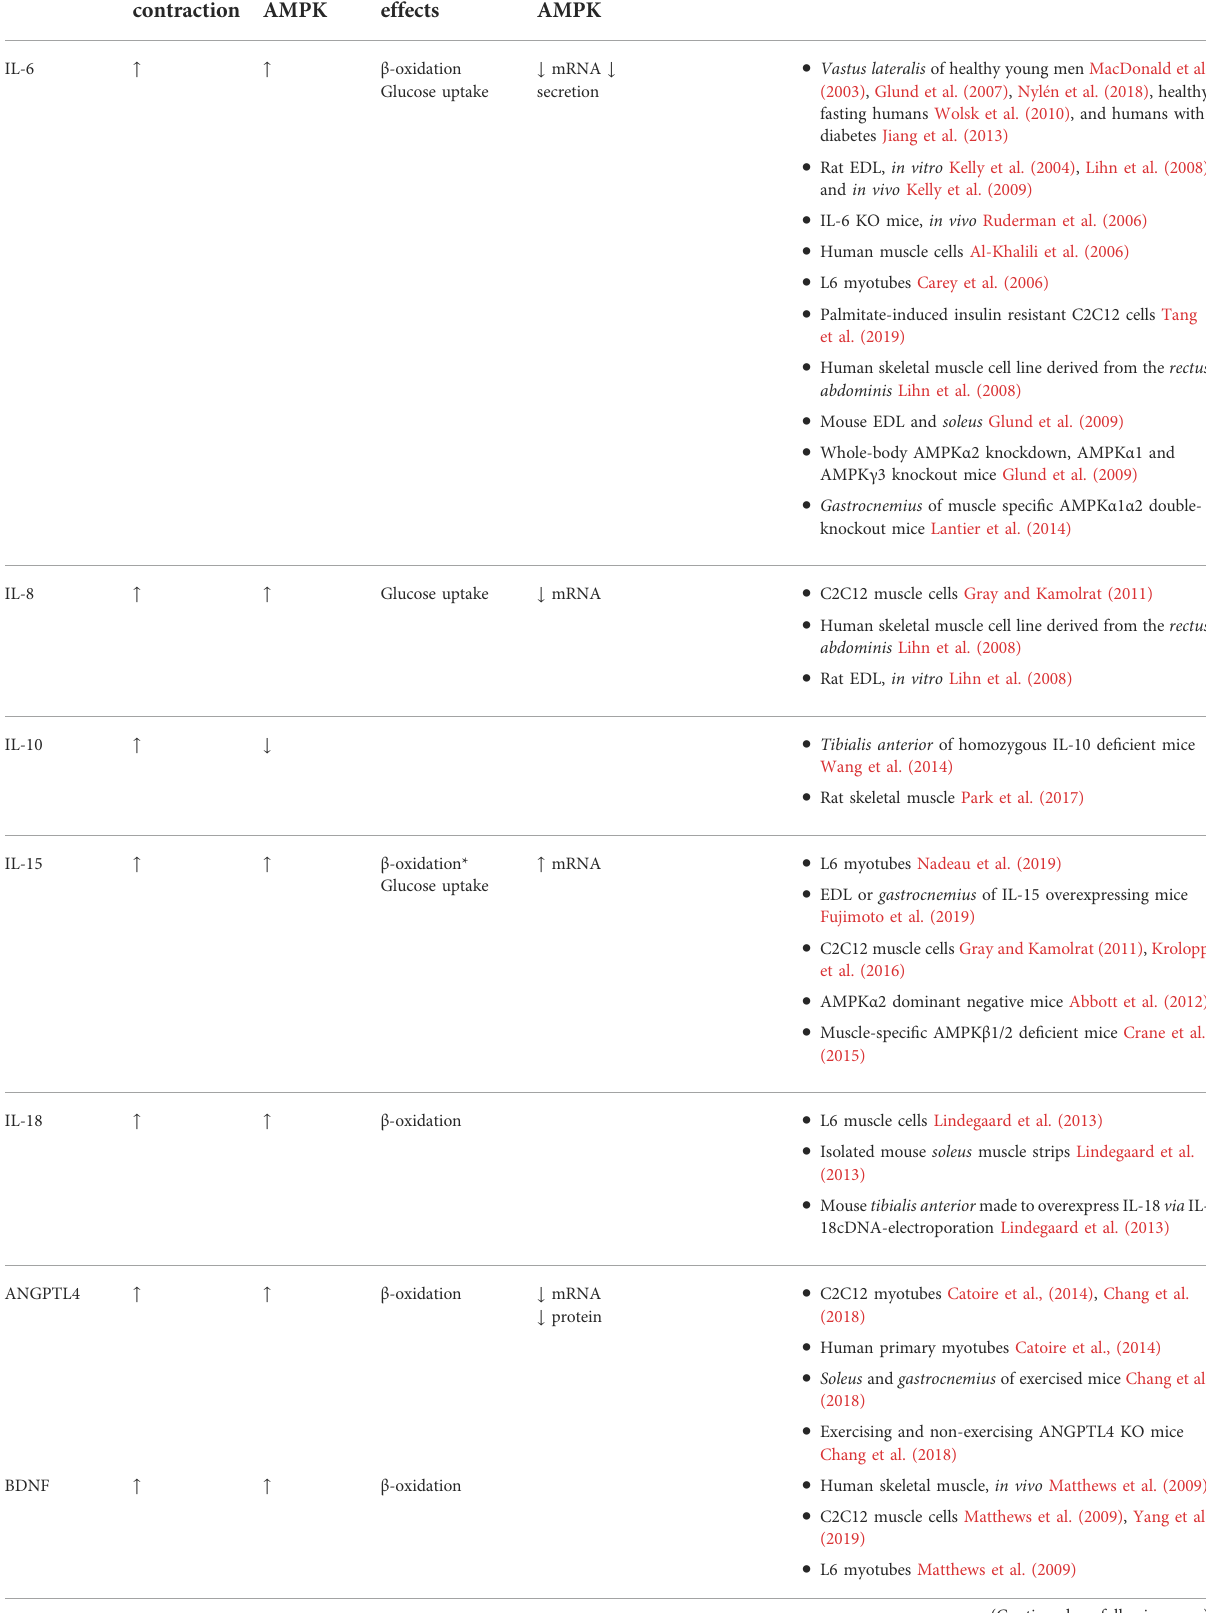
TABLE 1 Summary of the effects of the interactions between myokines and AMPK in skeletal